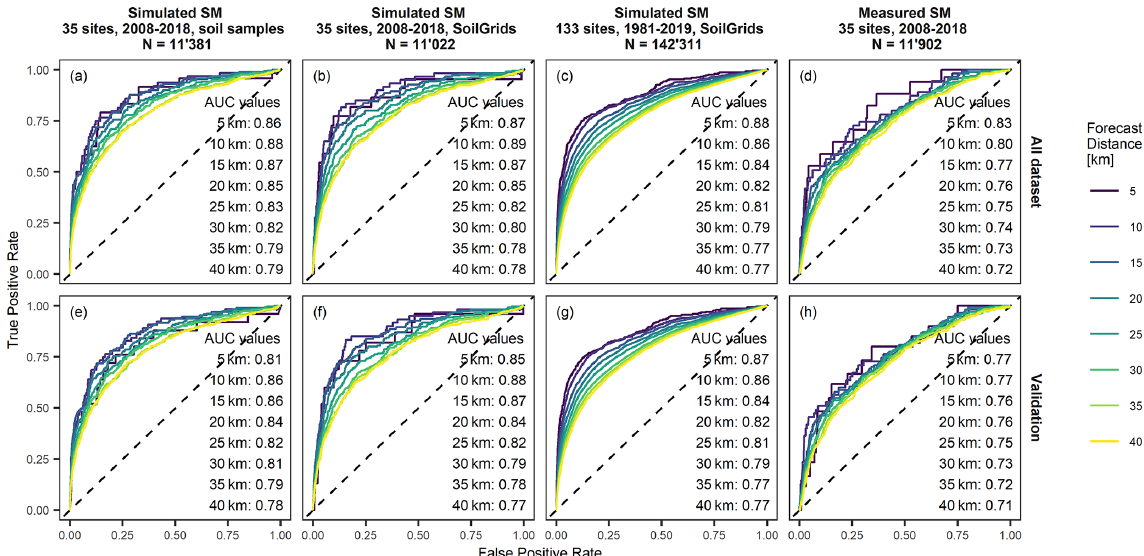
Figure 6. ROC plots and AUC values of landslide forecast model fits based on simulated soil moisture (SM) at the 35 monitoring sites, including soil hydrological properties from soil samples (a, e) and SoilGrids (b, f) at all 133 sites and including soil hydrological properties from SoilGrids (c, g) , and based on measured soil moisture at the 35 monitoring sites (d, h) . All CoupModel set-ups include a lower boundary condition with groundwater. Panels (a) – (d) show landslide forecast model fits using all the data sets, whereas panels (e) – (h) show model fits based on the fivefold cross-validation